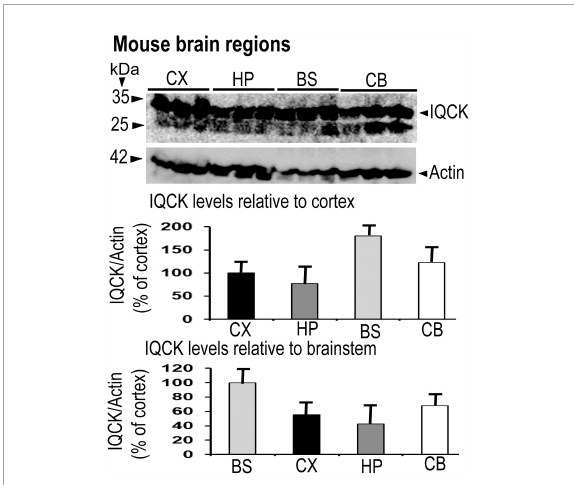
FIGURE4 Demonstration of IQCK protein expression in different brain regions of 12-month-old mice by immunoblots. Mouse brain regions were lysed, and the lysates were subjected to SDS-PAGE electrophoresis. Protein levels of actin utilized as a loading control were used to normalize IQCK protein levels. Relative to the cortex (CX), IQCK expression levels in the hippocampus (HP) was 77%, in the brainstem (BS) was 180% and in the cerebellum (CB) was 123%. Relative to BS, the levels were 55% in the CX, 43% in the HP, and 68% in the CB.